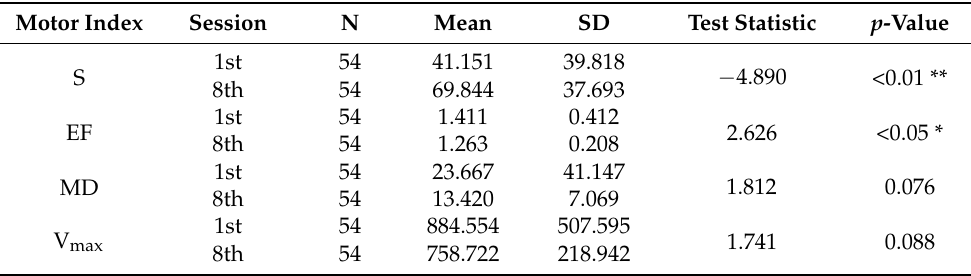
Figure 5. Motor trajectories in the VR task. Table 5. Summary statistics and paired t-test for comparing motor indecies in Mode 1 between the first and eighth training for the Tracing task.